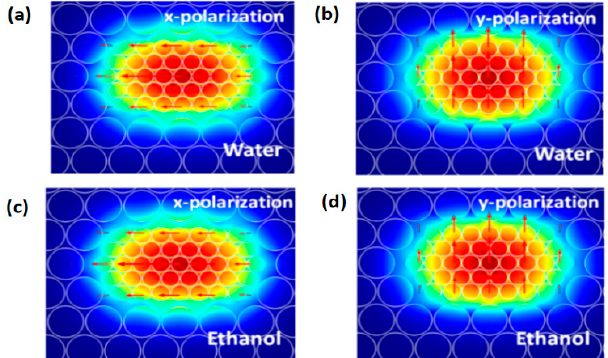
Figure 2. Electric field distribution of the fundamental mode in the proposed fiber at 1.6 THz: ( a ) x -polarization for water-filled core; ( b ) y -polarization for water-filled core; ( c ) x -polarization for ethanol-filled core; and ( d ) y -polarization for ethanol-filled core.